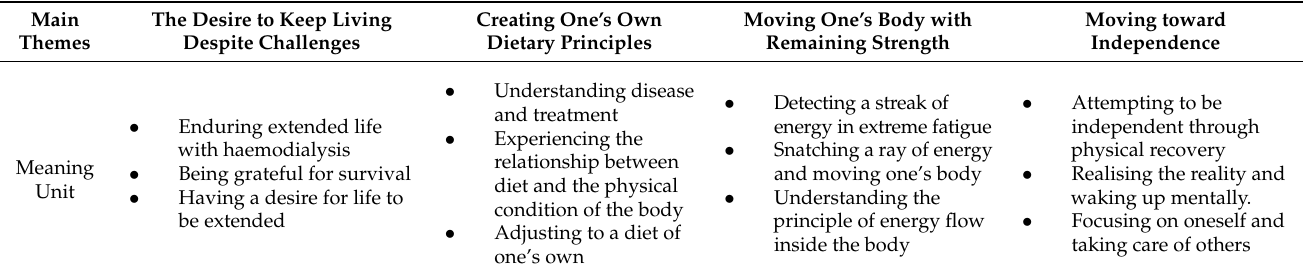
Table 3. Four themes of self-care in patients undergoing long-term